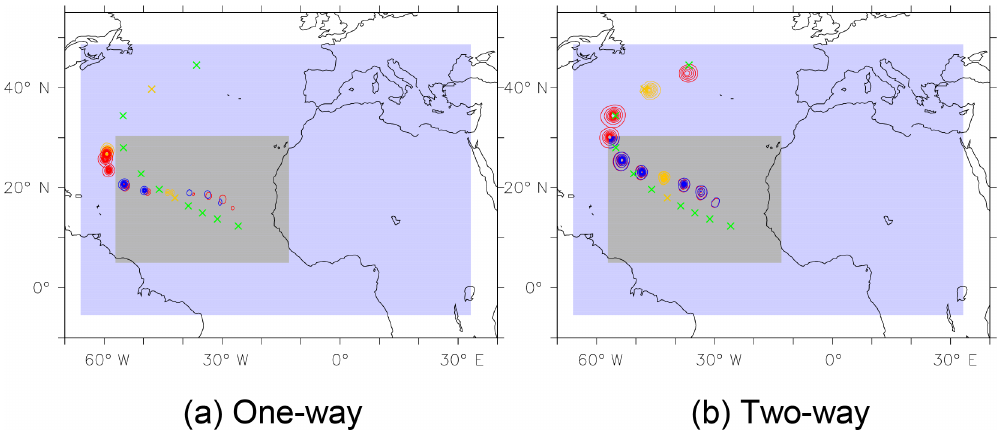
Figure 11. Track position for hurricane Isaac in the one-way (a) and two-way (b) coupled simulations. The daily SLP (less than 1005hPa, 5hPa intervals, in the area of 0–50 ◦ N and 65–25 ◦ W, starting on 23 September, 00:00UTC) is shown as contours for the COSMO/MESSy instances (red: COSMO/MESSy 0 . 22 ◦ , blue: COSMO/MESSy 0 . 11 ◦ ). The best track position from HURDAT is marked as reference (green crosses). To allow for a temporal comparison, the positions on 26 September and 1 October are yellow coloured for all tracks. The different model domains of the COSMO/MESSy instances are shaded (blue: COSMO/MESSy 0 . 22 ◦ , grey: COSMO/MESSy 0 . 11 ◦